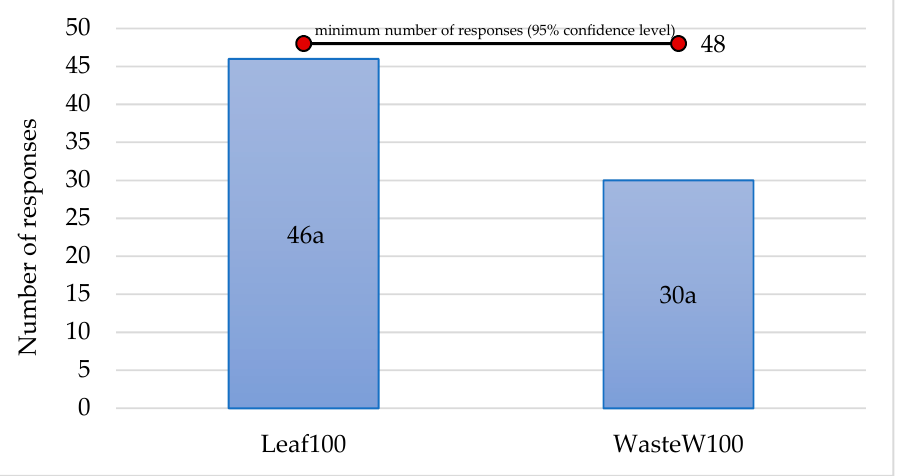
Figure 2. Differences in the number of responses accorded by consumer to the Leaf100 and WasteW100 samples in the paired comparison test.